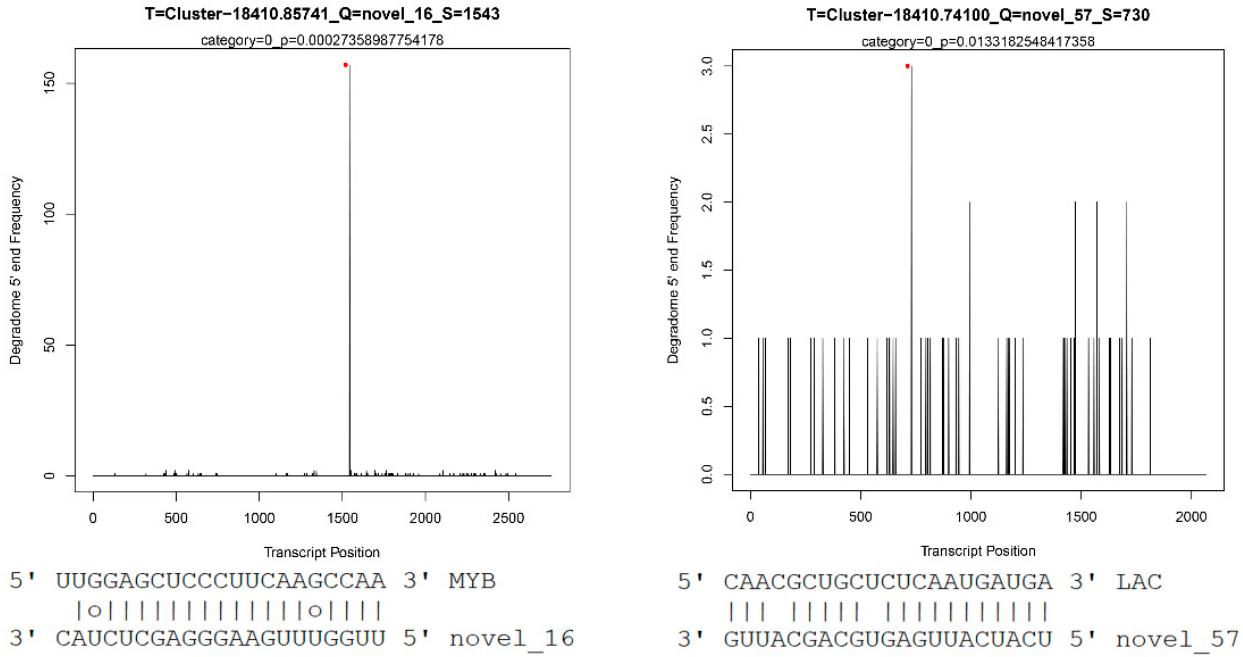
Figure 6. miRNA targets involved in lignin biosynthesis. miRNA cleavage is represented by solid lines with “T” arrows.